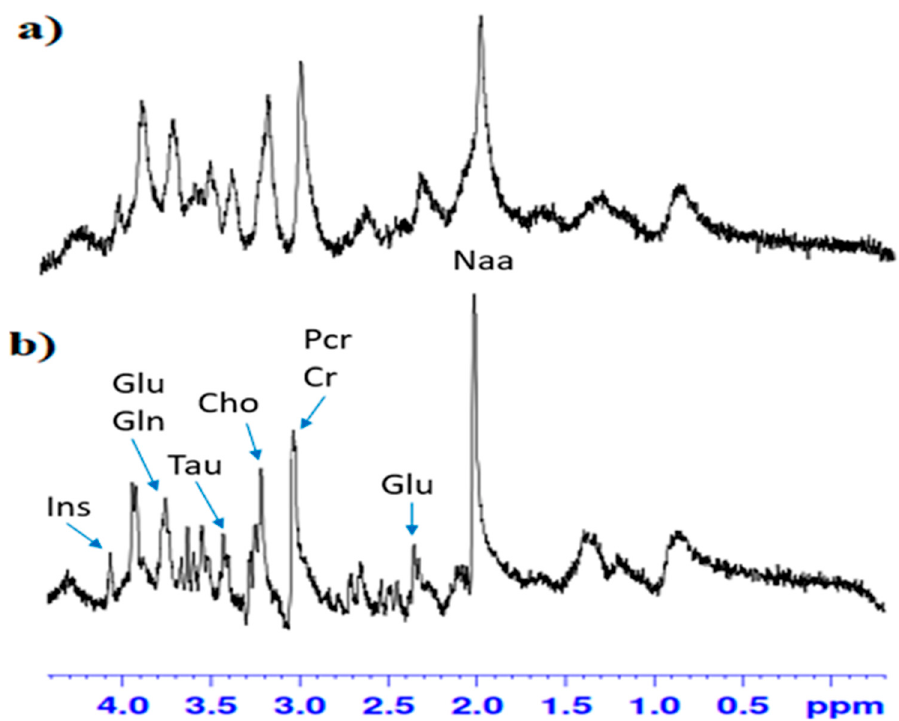
Figure 2. Typical in-vitro proton magnetic resonance spectroscopy ( 1 HMRS) spectrum in the dentate gyrus (DG) of hippocampus ( a ) in group fed with alcohol, ( b ) in control group. 7T Bruker, animal system. Inositol (Ins), glutamate (Glu), glutamine (Gln), taurine (Tau), choline (Cho), total creatine (PCr + Cr), N-acetylaspartate (Naa).